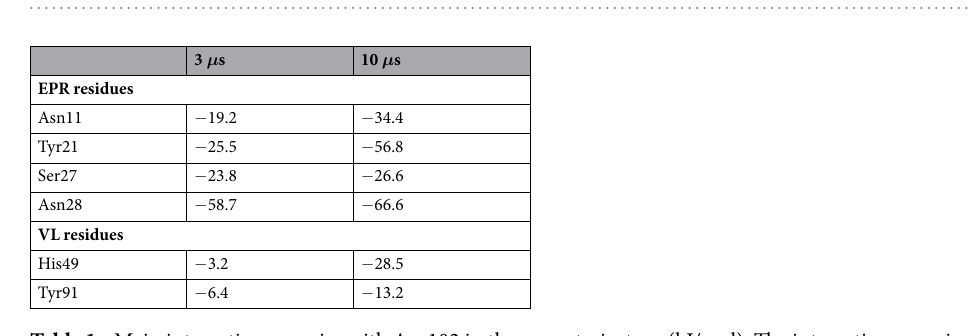
Figure 5. The CDR-H3 loop structure of the cis-complex for the green trajectory at 10 μ s. The CDR-H3 loop is shown in red. The heavy chain, light chain, and EPR are coloured cyan, magenta, and green, respectively. The hydrophobic residues Pro103, Val104, Phe105, and Val106 in the CDR-H3 loop and Leu46 in the light chain are shown as a grey surface as well as thin sticks. Leu46 interacts with the hydrophobic residues of the CDR-H3 loop. Hydrogen bonds are shown with black dashed lines. Arg95 (orange stick) in the light chain is predicted to be a residue which may form a contact with Asp102 during isomerisation. Residues are represented using the one-letter code for amino acids.